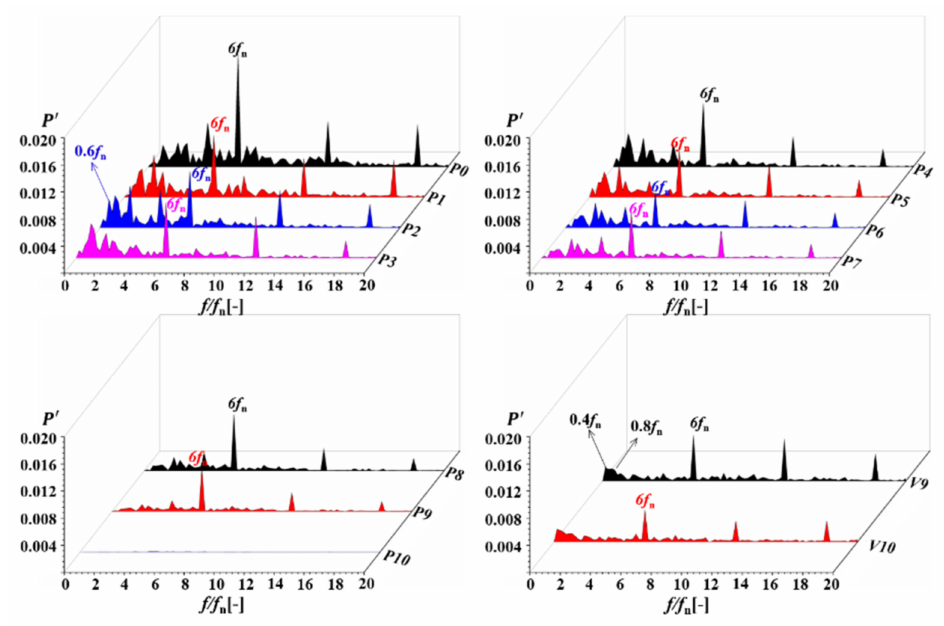
Figure 18. Frequency domain of pressure fluctuation at the 0.7 Q b operation condition.